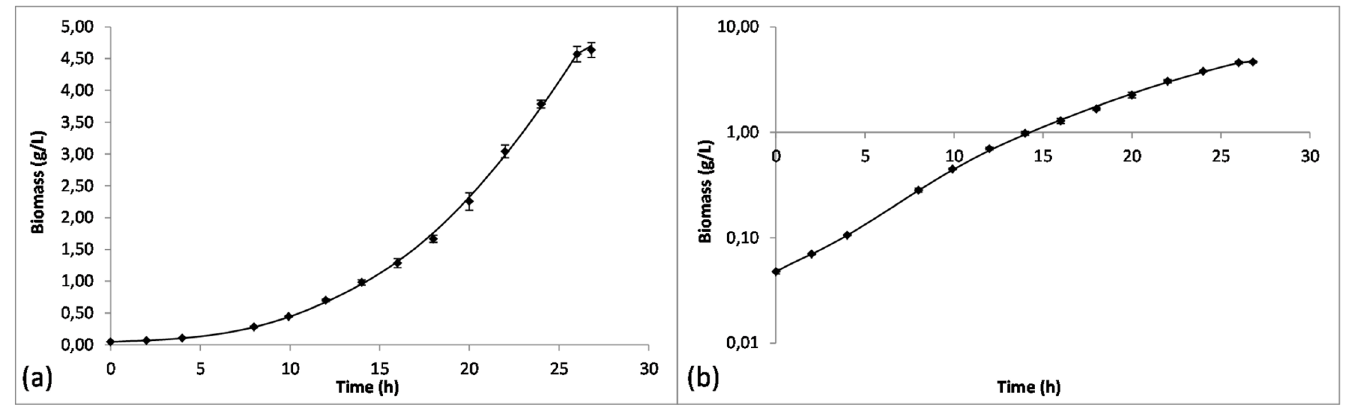
Fig 1. Kinetics of growth of B . pertussis Tohama I in batch cultures. Results are displayed as mean values for the three biological replicates with a regular Y-scale (a) and a logarithmic Y-scale (b). Error bars represent the replicates' standard deviations. Dry cell weight concentrations have been calculated from OD measurements at 650